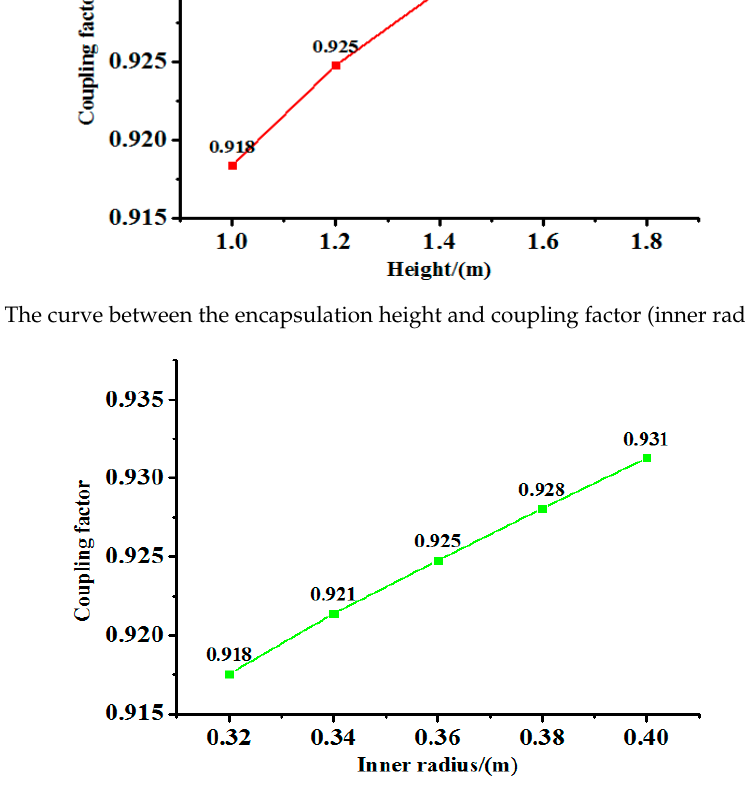
Figure 12. The fitted curve between the inner radius and encapsulation height.